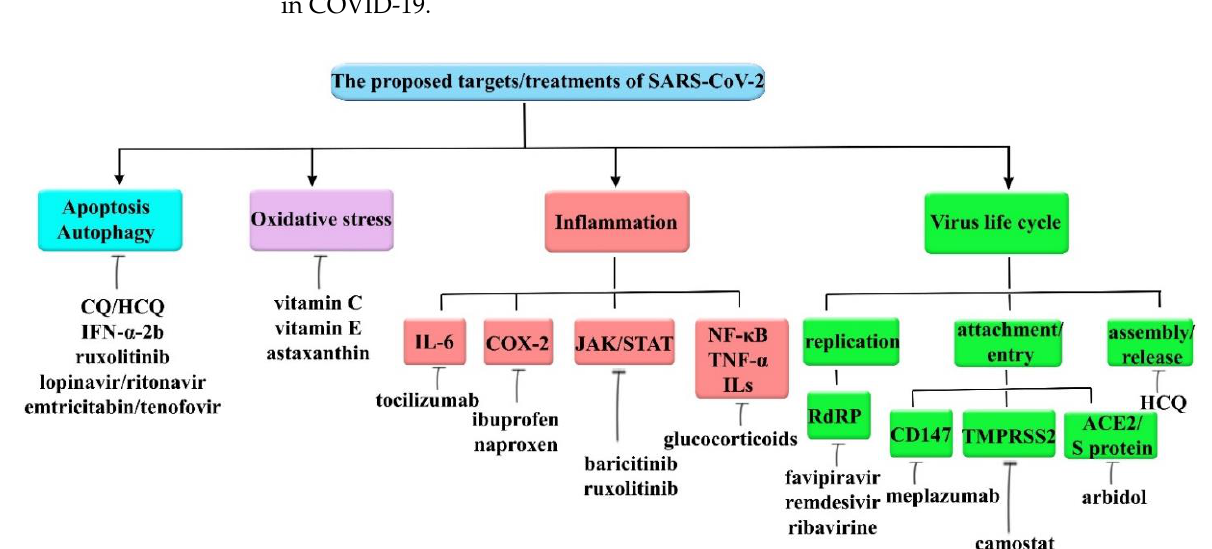
Figure 2. The proposed targets and related therapeutic candidates in SARS-CoV-2. Atg: autophagy-related; CAT: catalase; CQ: chloroquine; HCQ: hydroxyl chloroquine; GST-1 α : glutathione s-transferases-1 α ; HO-1: heme oxygenase; IFN: interferon; IL: interleukin; JAK/STAT: Janus kinase (JAK)/signal transducer and activator of transcription (STAT); LC3: light chain 3; NF- κ B: nuclear factor kappa B; ROS: reactive oxygen species; RTK: receptor tyrosine kinase; SARS-CoV-2: severe acute respiratory syndrome coronavirus 2; SOD: superoxide dismutase; TNF- α : tumor necrosis factor- α .